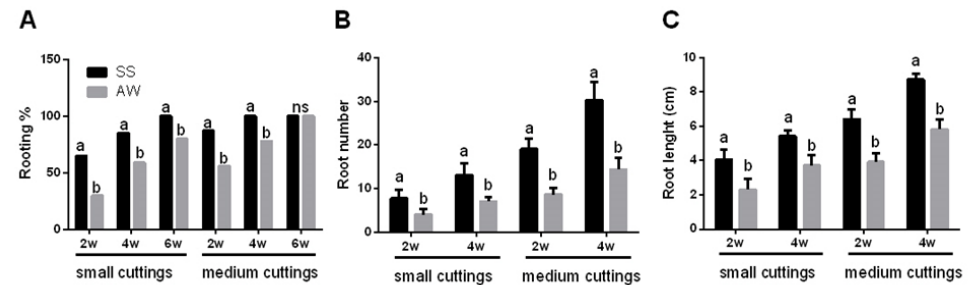
Figure 3. Effect of seasonal period on the rooting percentage ( A ), root number ( B ) and length in pitaya small and medium-sized cuttings ( C ). For each parameter and each group considered, columns labeled with di ff erent letters are significantly di ff erent (at p < 0.05). Student’s t -test was used to compute the